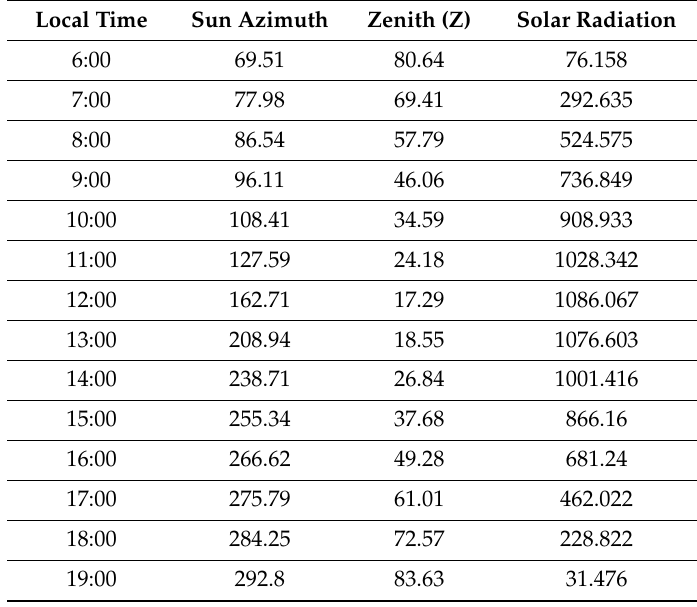
Table 3. The values of the azimuth and elevation for whole hour equal intervals for the center of the chosen scene on 13 July